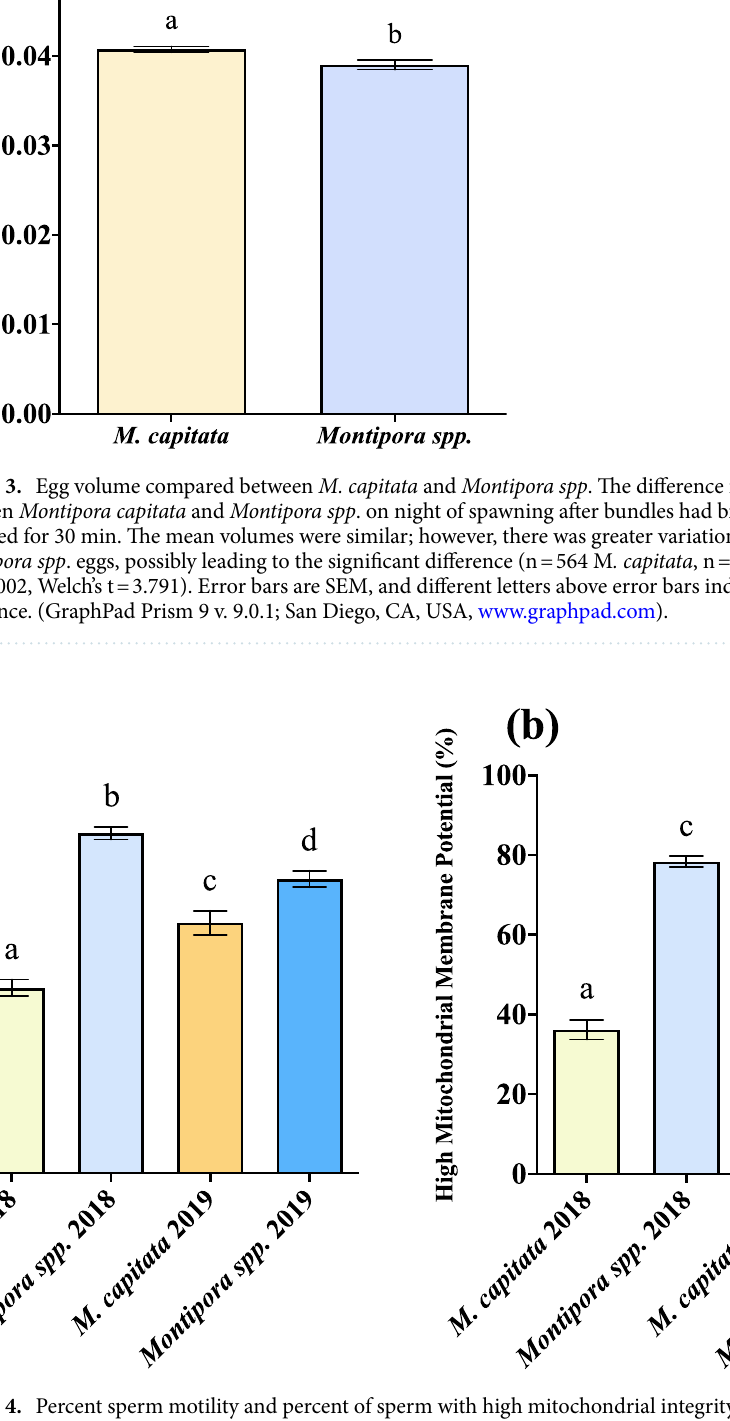
Figure 4. Percent sperm motility and percent of sperm with high mitochondrial integrity. ( a ) The difference in mean percent total sperm motility (2018: n = 55 M . capitata , n = 50 Montipora spp .; 2019: n = 23 M . capitata , n = 61 Montipora spp .; see Table S2 in Supplementary Information for two-way ANOVA results). While sperm motility declined in Montipora spp . and improved in M. capitata from 2018 to 2019, total motility was still greater in Montipora spp. than M. capitata both years. ( b ) The percent of sperm with high mitochondrial membrane potential (2018: n = 55 M . capitata , n = 50 Montipora spp .; 2019: n = 23 M . capitata , n = 61 Montipora spp .; see Table S3 in Supplementary Information for two-way ANOVA results). The percent of sperm with high mitochondrial membrane integrity maintained a similar level in Montipora spp ., and while it significantly improved in M. capitata from 2018 to 2019, Montipora spp . was significantly greater both years. Error bars are SEM, and shared letters above error bars indicate no significant difference as determined by post hoc test of two- way ANOVA. (GraphPad Prism 9 v. 9.0.1; San Diego, CA, USA, www. graph pad.